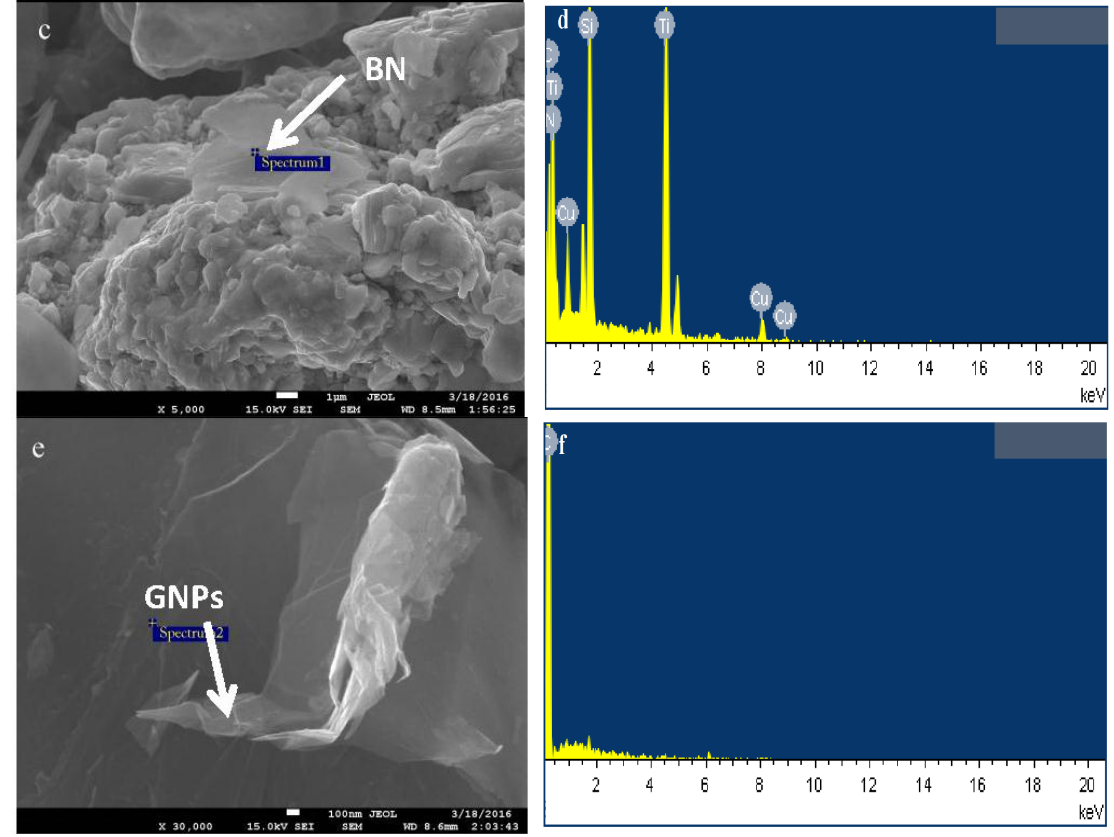
Figure 2. SEM images of the ball-milled powders: ( a ) GNPs/Cu composite powders 300×; ( b ) GNPs/Cu composite powders 5000×; ( c ) Cu/Ti 3 SiC 2 /C/BN/GNPs composite powders 5000×; ( d ) Energy dispersive X-ray spectrometer (EDS) element analysis of the white flake-like phase marked in ( c ); ( e ) Cu/Ti 3 SiC 2 /C/BN/GNPs composite powders 30,000×; ( f ) EDS element analysis of the white layered phase marked in ( e ).